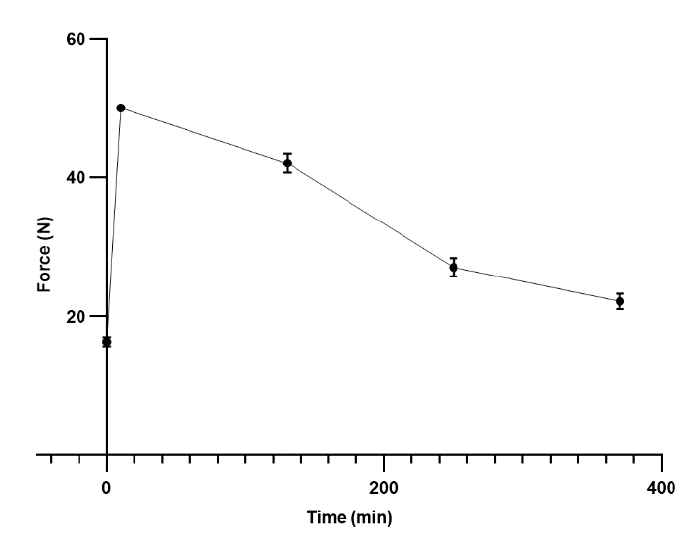
Figure 4. The least-squares means ( ± SEM) shows the obtained nociceptive thresholds or forces (N) at di ff erent time points after ring block with articaine hydrochloride 4% (Each data point represents 10 animals). Table 1. The least-squares means ( ± SEM) of MNT (N) for algometry validation and articaine study. The values below depict MNT disregarding antler side and site. N = 40 animals for the validation study, and 10 for articaine